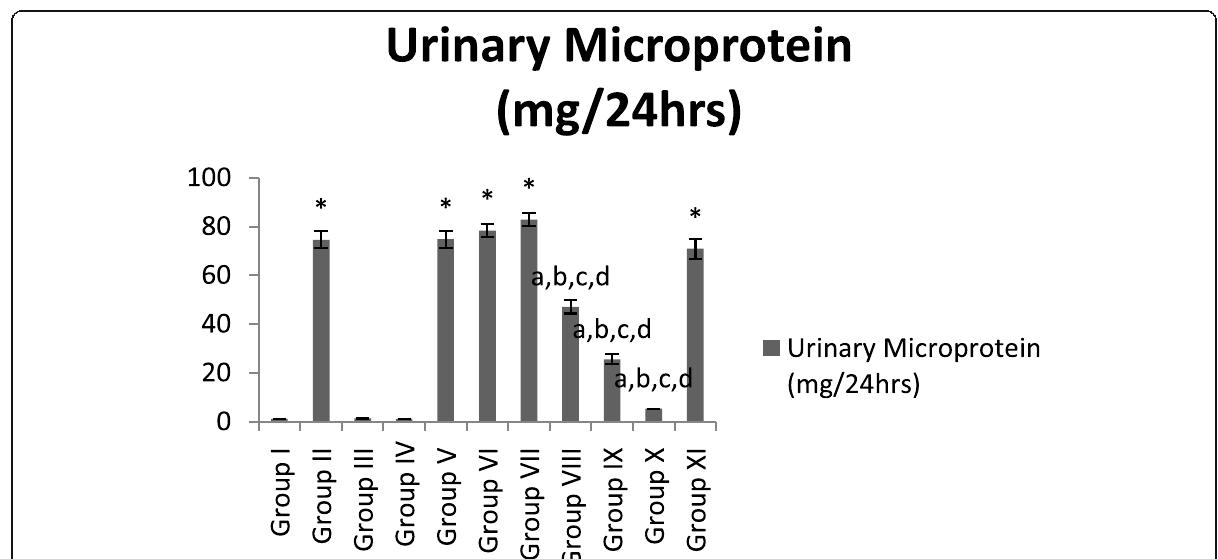
Fig. 3 Graph representing urinary microprotein levels (mg/24h). All values were represented as mean ± SEM. *= p < 0.001 versus group I (normal control); a = p < 0.001 versus group II (uninephrectomised diabetic control); b = p < 0.001 versus group V (uninephrectomised diabetic rats with oleamide (1mg/kg) treatment; c = p < 0.001 versus group VI (uninephrectomised diabetic rats with oleamide (2.5mg/kg) treatment); d = p < 0.0001versus group VI (uninephrectomised diabetic rats with oleomide (5mg/kg)